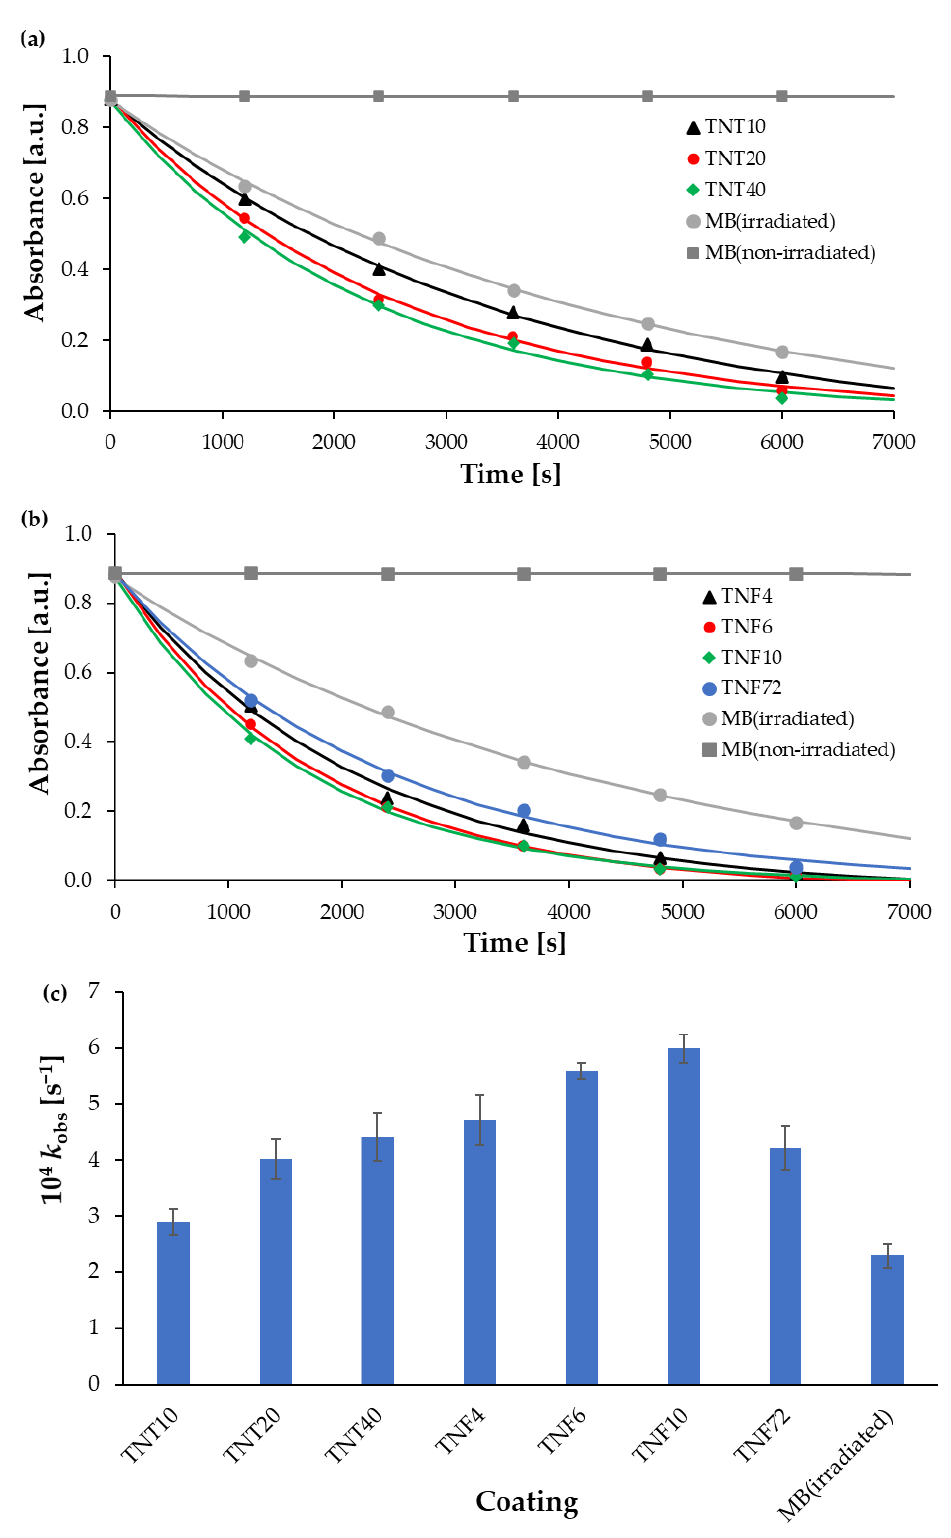
Figure 7. Kinetic runs recorded during MB photocatalytic decolorization with the use of TNT ( a ) and TNF ( b ) samples, and calculated observed rate constants ( c